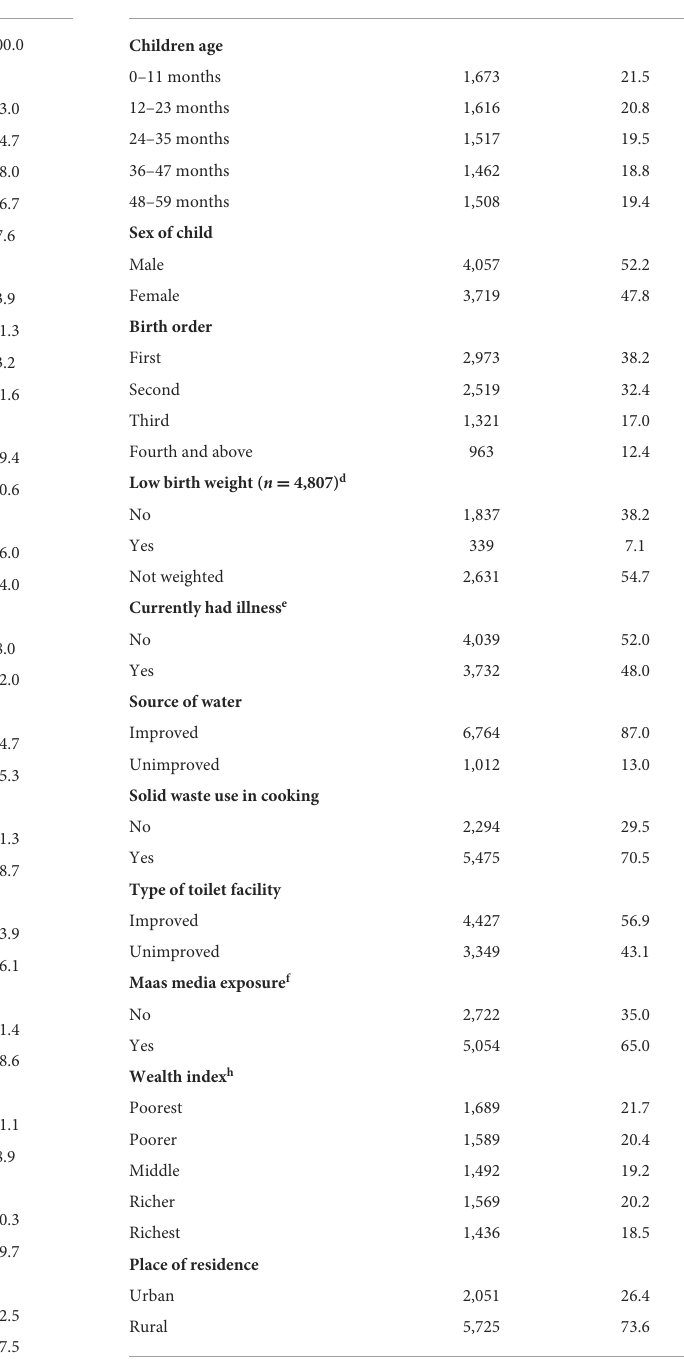
TABLE 2 Background characteristics of the